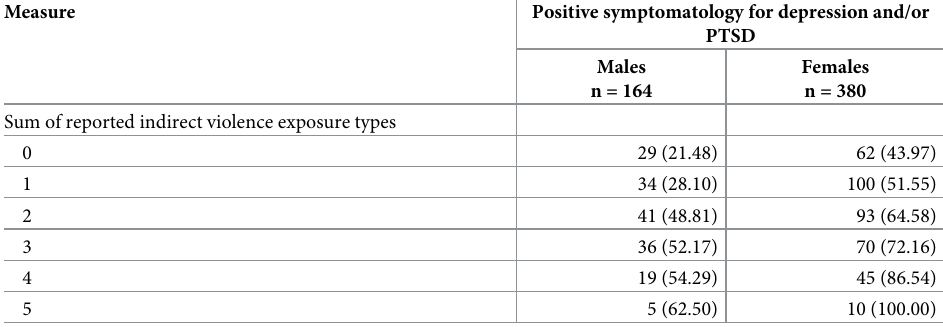
Table 6. Number of indirect exposure types and positive symptomatology for depression and/or PTSD by gender (N = 1548). Measure Positive symptomatology for depression and/or